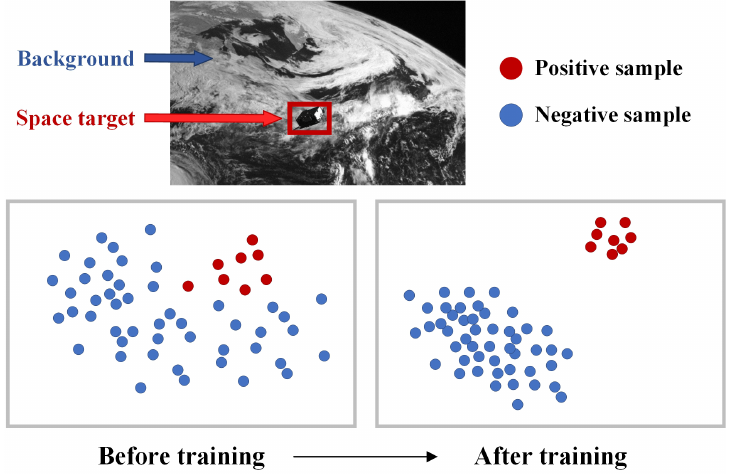
Figure 25. Increase the differences between target features and background features through con- trastive